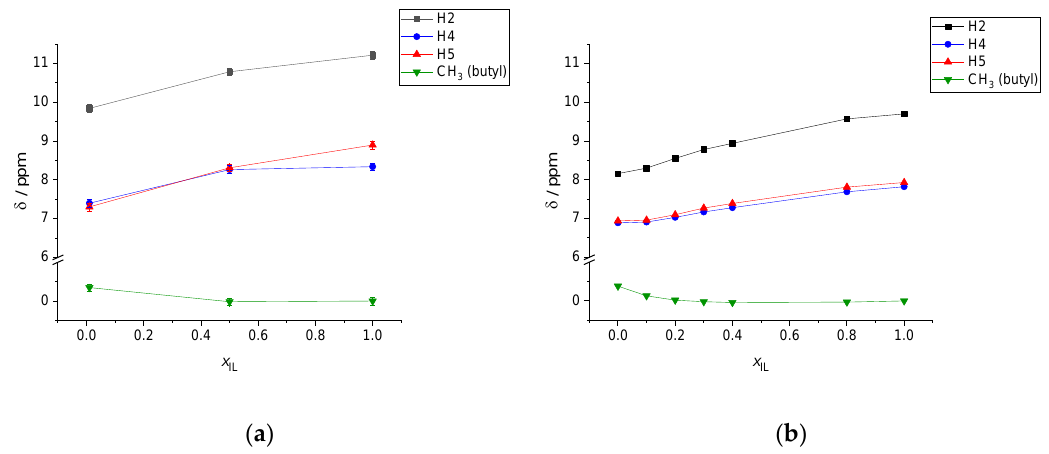
Figure 6. Chemical shifts as a function of the composition of the [C 4 C 1 im]Cl / water mixture. ( a ) Average calculated values. ( b ) Experimental data from Ref. [25]. Connecting lines are merely a guide to the